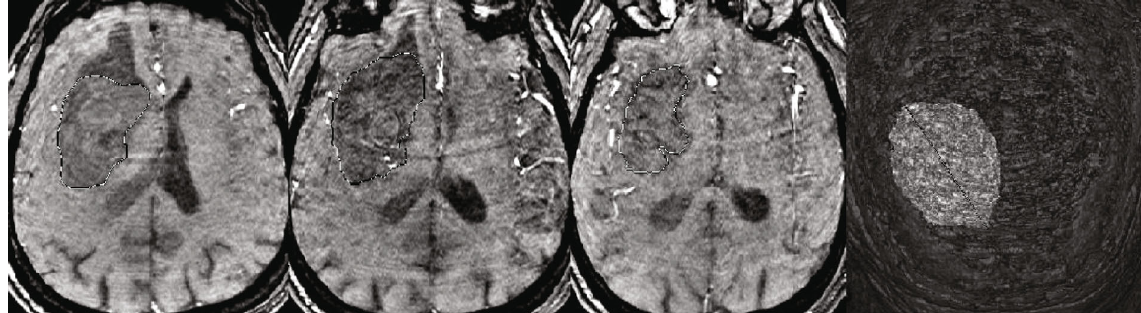
Figure 2: GRE axial section showing hematoma segmentation at the end of the examination and a 3D reconstruction of the hematoma with an obvious increase in its size referred to as the fl ood phenomenon.